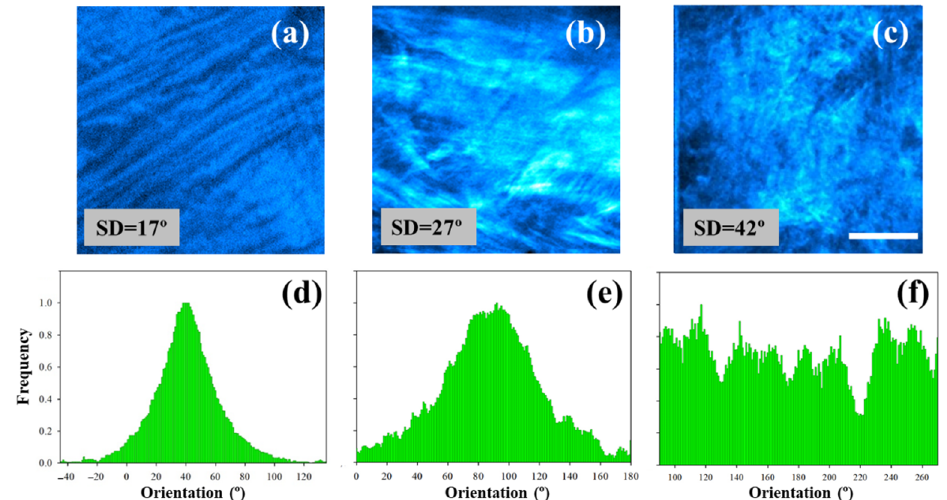
Figure 3. SHG images of non-pathological human corneas ( a , b ) and a cornea affected by keratoconus ( c ). Scale bar = 50 μm. ( d – f ) Histograms of PO distribution for the SHG images of the upper row. These were calculated using the structure tensor.